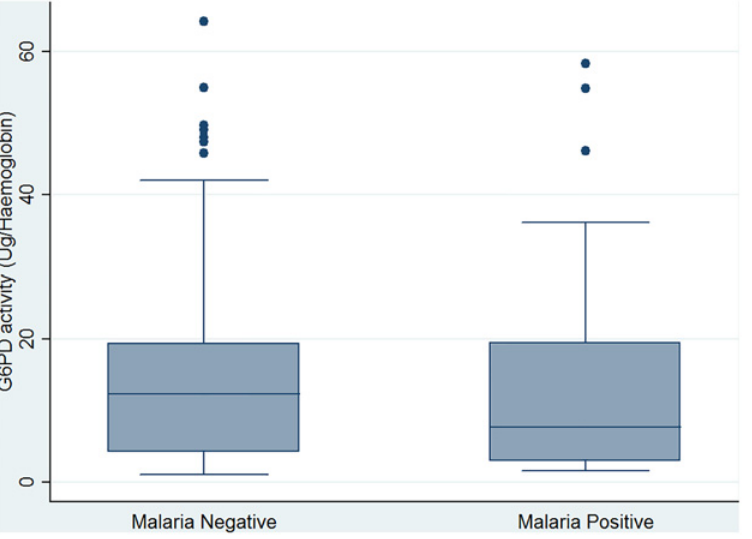
Fig 6. Estimates of G6PD enzyme activity levels by malaria parasite